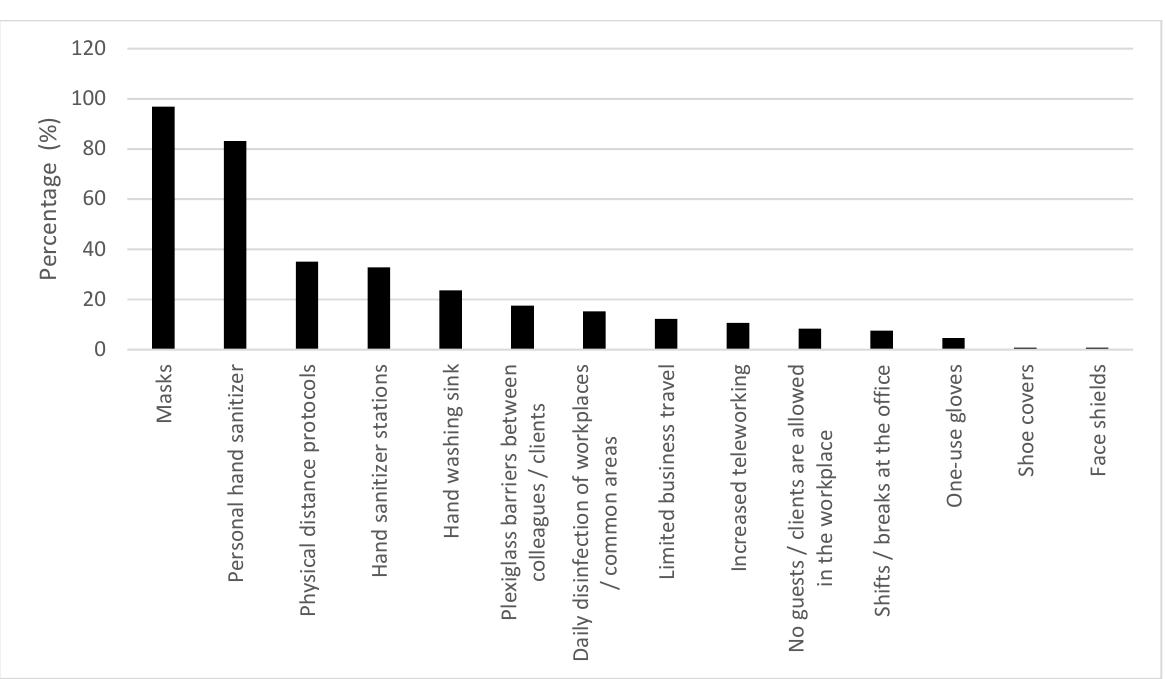
Figure 8. COVID-19 protocols applied on offices.